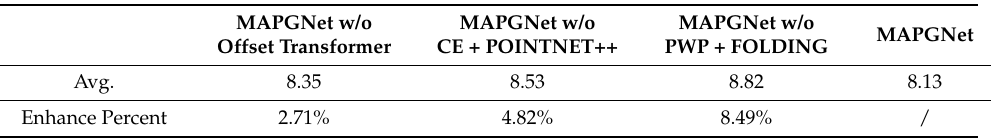
Table 8. Ablation experiments on dataset PCN, the results in terms of per-point chamfer distance (CD) with L1 norm computed on 16,384 points and multiplied by 10 3 . Enhance percent is the influence of the module on the overall promotion.